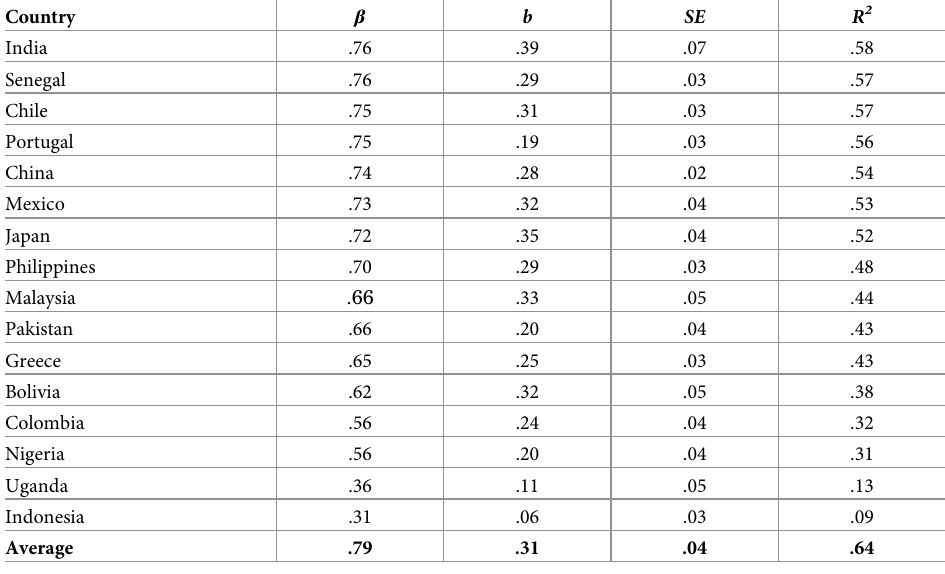
factor loadings for the 3 item IHS with an average reliability of .84 were estimated at .80. The average correlation between the observed SHS and IHS in the data was r = .59, which gives an estimated latent variable correlation of .69. Given these estimated parameters and an average sample size of 246 participants across countries, we estimated the power to detect an effect between the two latent happiness variables to approach